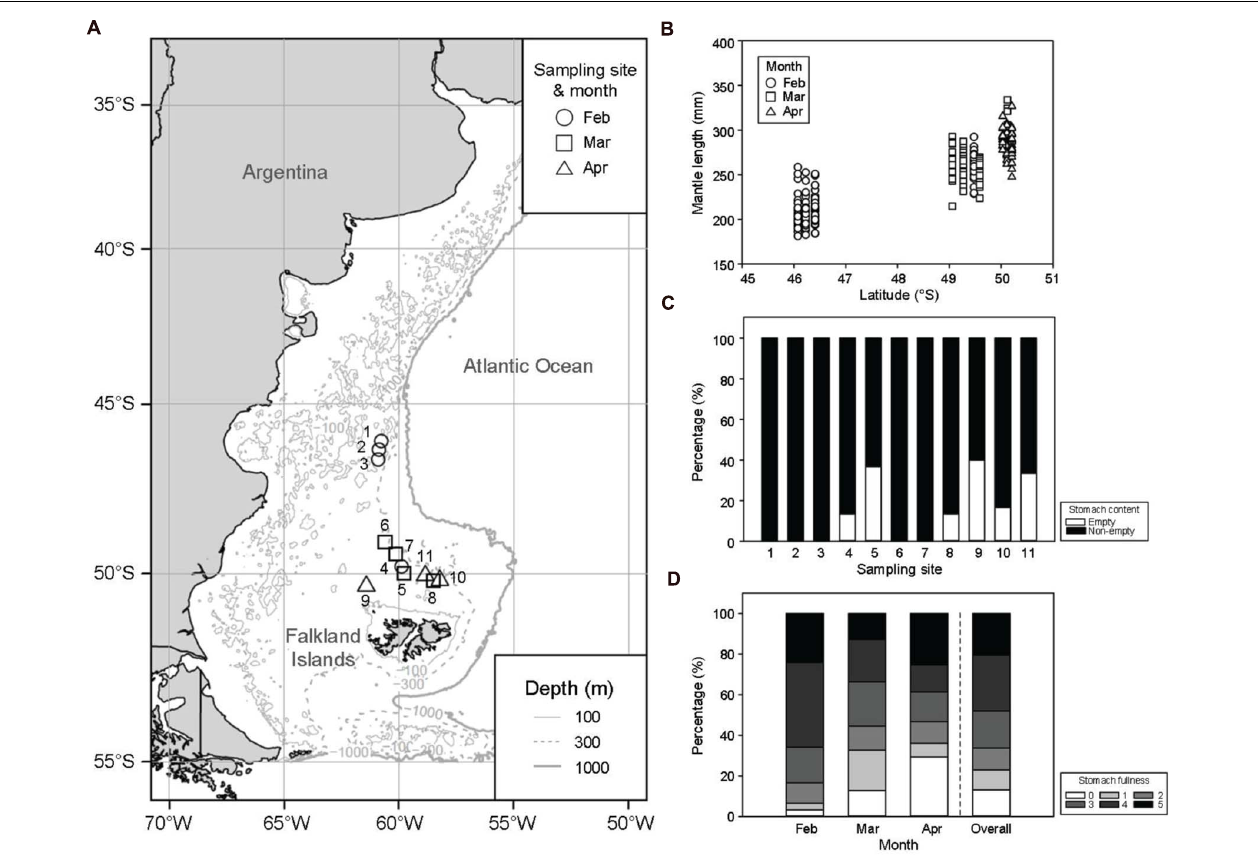
FIGURE 1 | (A) Map of the Southwest Atlantic and sampling sites for the Argentine shortfin squids Illex argentinus captured from February to April in 2018 and 2019 in the study area. Gray thin solid, dashed, and thick solid lines represent depths of 100, 300, and 1000 m, respectively. (B) The correlation between mantle length of squids and latitudes of sampling sites. (C) The percentage of condition of stomach contents and stomach fullness shows the distribution of non-empty (black) and empty (white) stomachs at each site, and (D) shows the monthly distributions. Scores from 0 to 5 are separately indicated as empty, scarce, few, half full, full, and full to